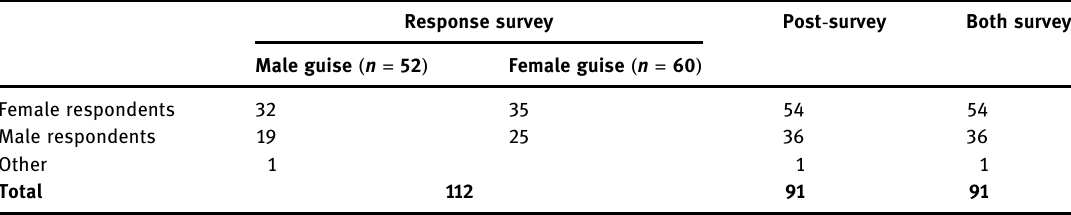
Table 1: Participants